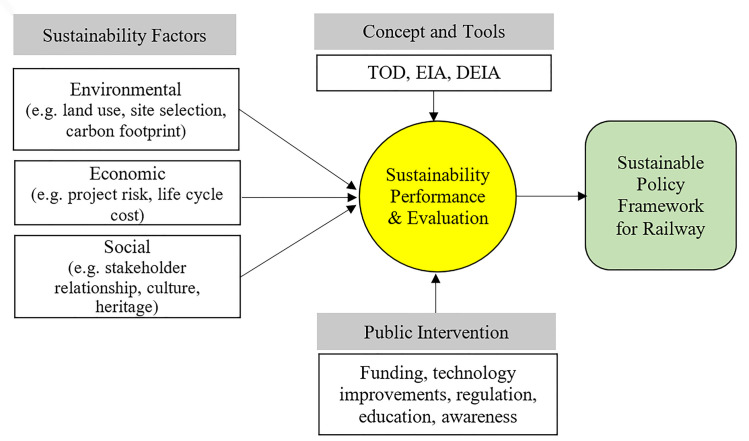
Research framework.